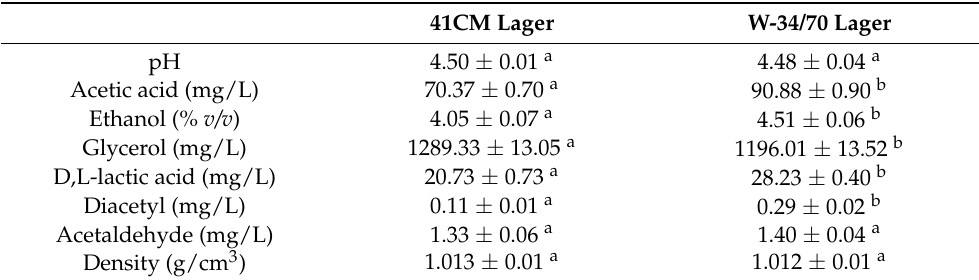
Table 2. Physicochemical parameters of the lager beers obtained using S. cerevisiae 41CM and S. pastorianus W-34/70 starters. Different lowercase letters in each row represent significant differences ( p < 0.05). Results are shown as mean ± SD ( n =